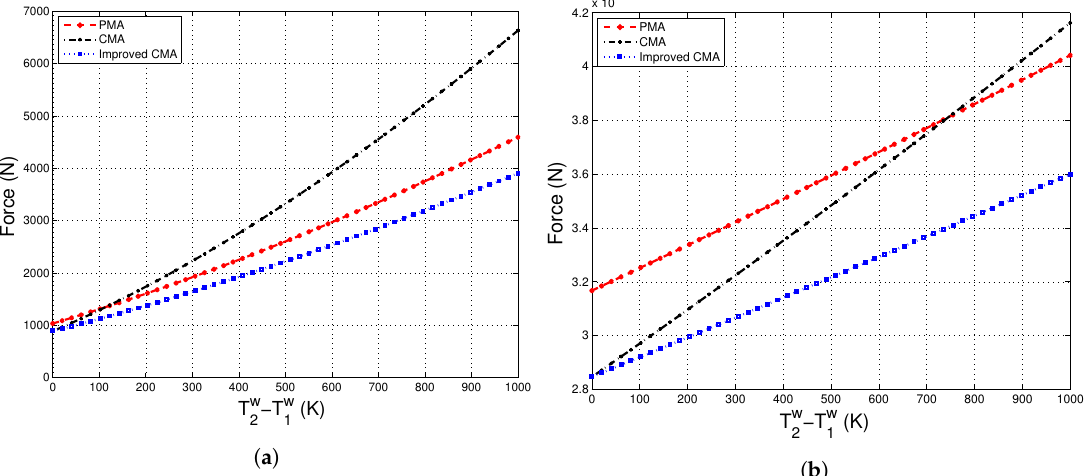
− T w , evaluated at different compaction 2 1